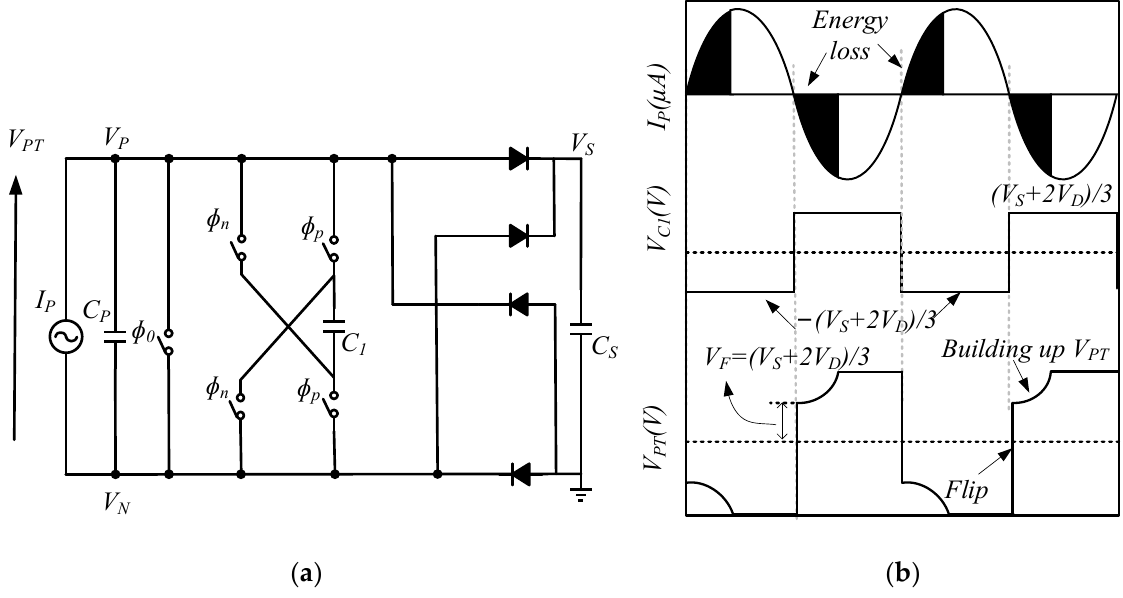
Figure 11. SSHC ( a ) with one charge-swap capacitor, ( b ) waveforms